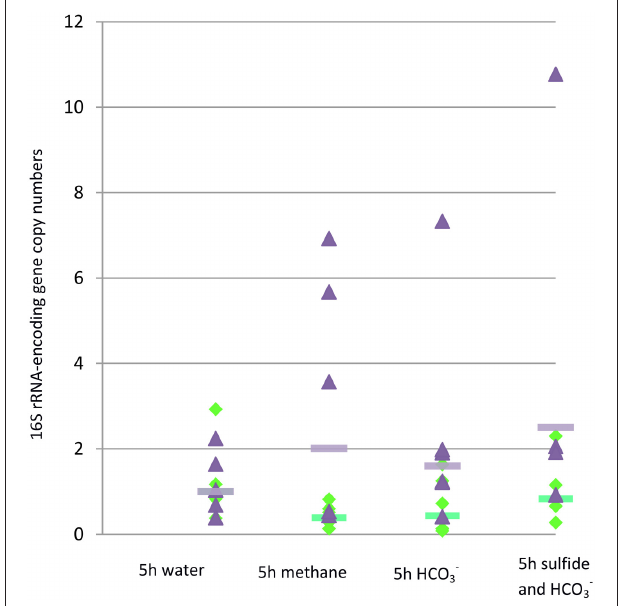
FIGURE 4 | Number of copies of genes encoding 16S rRNA from methane- and sulfur-oxidizers (green diamonds and purple triangles, respectively) in gill tissue of individual mussel specimens from treatments C to F estimated by qPCR normalized vs. average value of the control 5 h exposure to seawater. Average values for MOX and SOX of the specimens from each treatment, normalized vs. average value of the control 5 h exposure to seawater, are represented by green and purple lines,